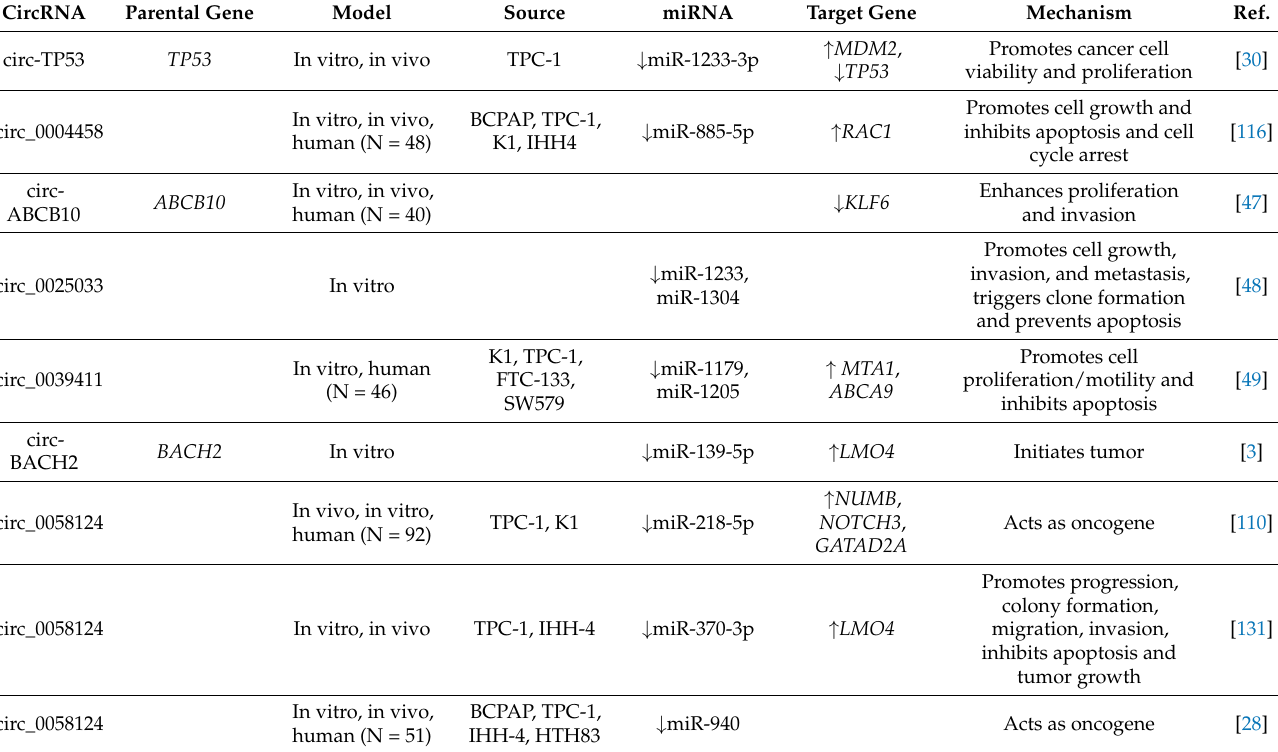
Table 3. Upregulated circRNAs promote thyroid tumor